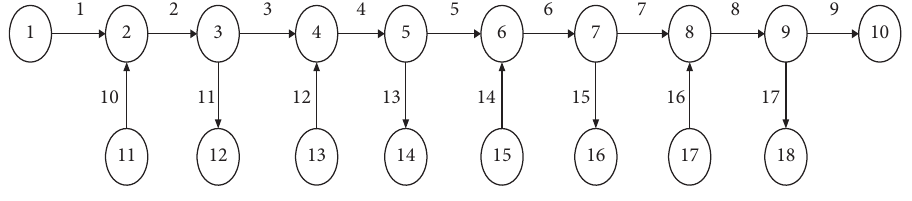
Figure 3: Simulation structure.